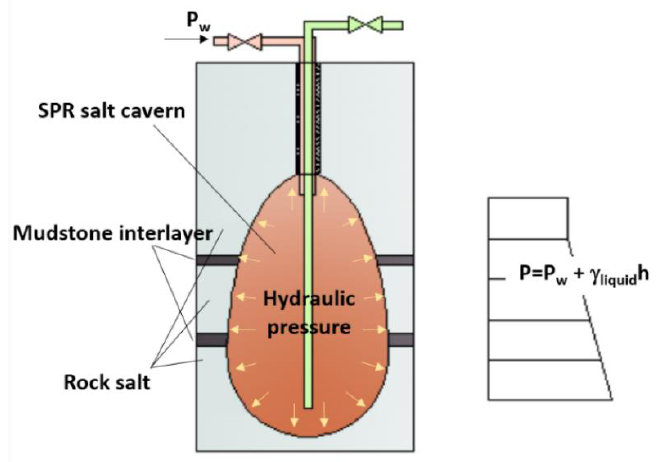
Figure 5. The hydraulic pressure schematic graph of the SPR salt cavern.